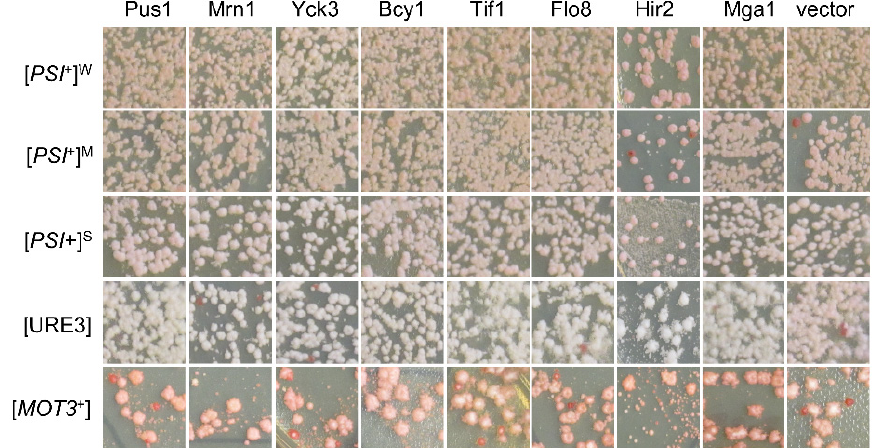
Figure 3. Identified [ SWI + ] destabilizers showed no significant effects on the propagation of the indicated non-[ SWI + ] yeast prions. Upon overproduction of each of the 15 proteins (in red text in Figure 2a), the statuses of the indicated prions were examined based on their colony’s colors on YPD plates, as described in the Methods. Cells losing prions would form red-like colonies on YPD. Shown are representative images from at least three repeated tests (more data are provided in Figure S1c).